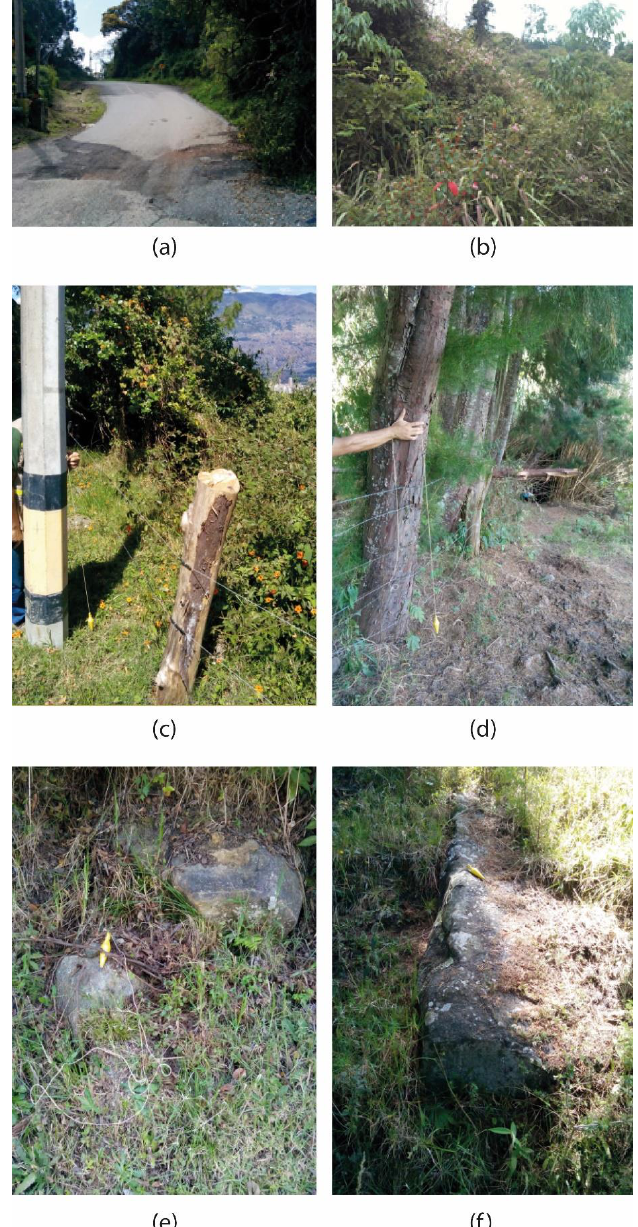
Figure 2. Some characteristics of the study area: ( a ) cracks, steps and subsidence on a road at the base of the study parcel; ( b ) dense native vegetation in the study site, with a mean slope of about 33%; ( c ) tilted posts in the slope direction; note the yellow plumb indicating the vertical; ( d ) tilted pine trees; note the yellow plumb; ( e ) rock boulders cropping out within the study parcel; ( f ) angular boulder within the study parcel; yellow plumb in ( e , f ) is shown for scaling purposes.